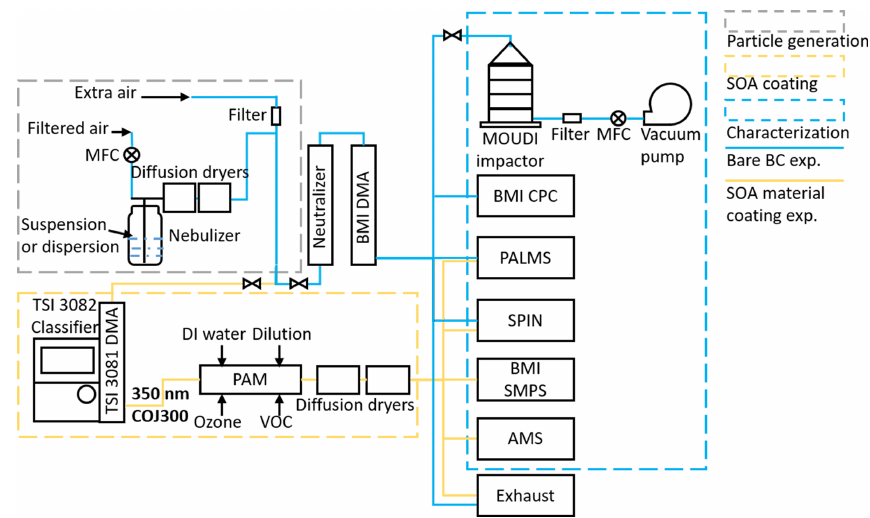
Figure 1. Schematic diagram of the experimental apparatus for bare BC particles (blue lines) and organic SOA coating experiments (yellow lines). The box with the gray dashed line encloses the particle-generation section, which is used for both bare BC and organic SOA coating experiments. The box with the yellow dashed line denotes the SOA coating section. The box with the blue dashed line is the aerosol characterization and test